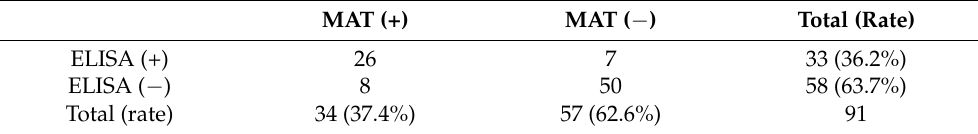
Table 1. Contingency table for detection of T. gondii antibodies in sera of hunting dogs by commer- cial ELISA in comparison with MAT (n = 91).